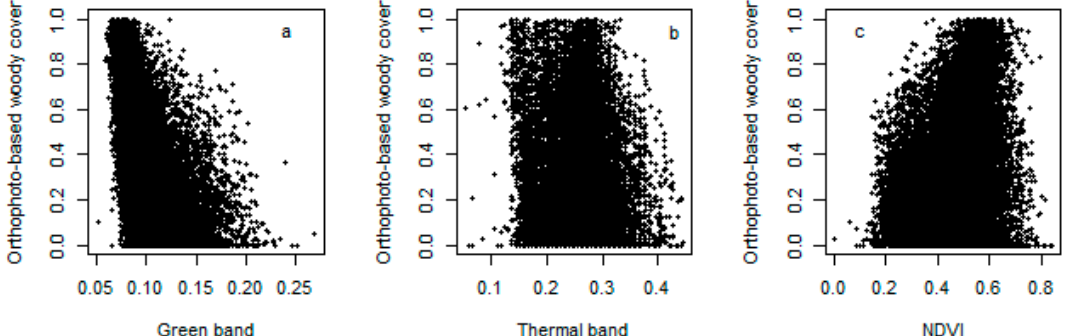
Figure 3. The scatterplots of fractional woody cover vs. green band ( a ), thermal band ( b ), and NDVI ( c ).